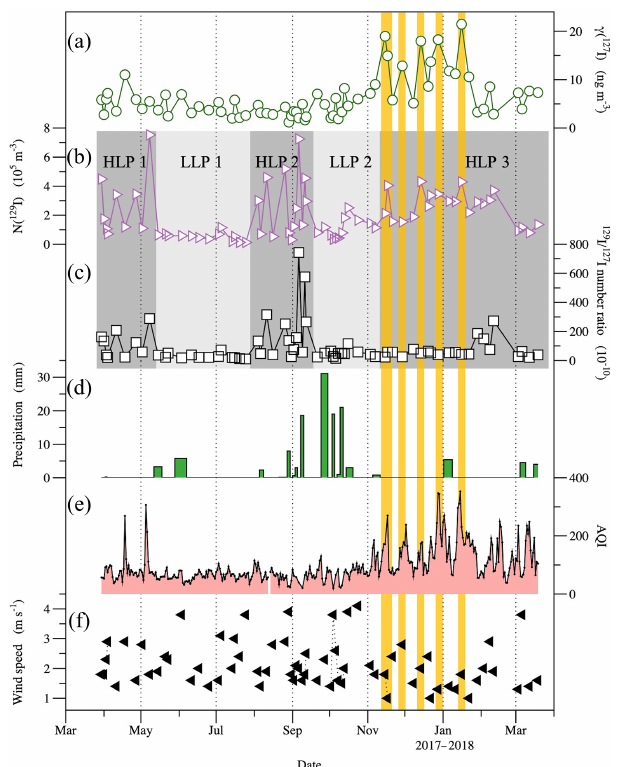
Figure 3. Monthly variation in (a) γ( 127 I ) , (b) N ( 129 I ) and (c) 129 I / 127 I number ratio in aerosols from March 2017 to March